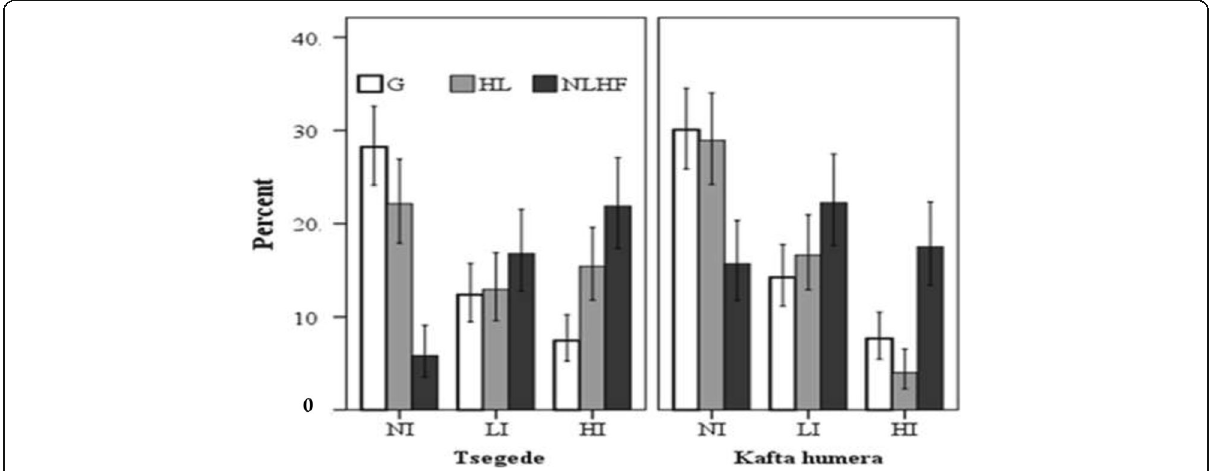
Fig. 4 Percentage of functional groups based on the frequency of occurrence (G grass species, HL herbaceous legumes, NLHF neither grasses nor legumes) of the herbaceous vegetation under three S. obtusifolia invasion levels (NI non-invaded, LI lightly invaded, HI heavily invaded) at two locations in northern Ethiopia. Bars indicate the SE of the mean